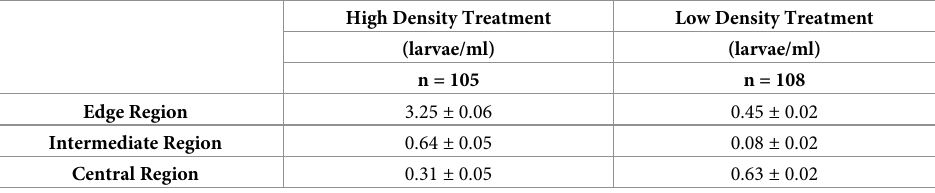
Table 3. Mean density of larvae observed in each region of containers ( ± 1